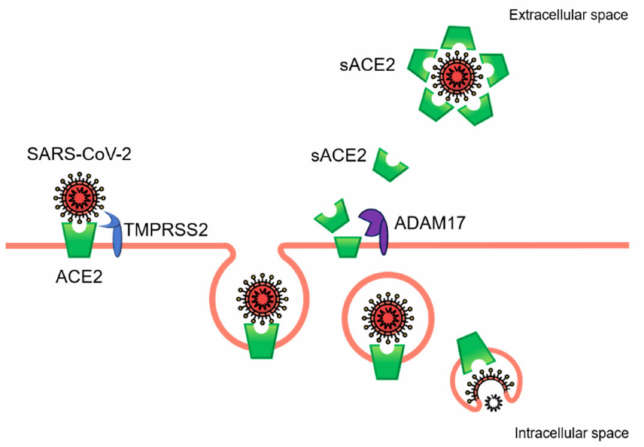
Figure 3. The fate of ACE2 during SARS-CoV-2 infection. After the binding of viral spike proteins to ACE2 and the S-protein priming by the transmembrane serine protease 2 (TMPRSS2), the viral particles are endocytosed. Acidification of the endosome leads to viral and cellular membrane fusion and the release of viral single-stranded RNA into the cytosol. The internalization of ACE2 contributes to the upregulation of ADAM metallopeptidase domain 17 (ADAM17), which cleaves the extracellular portion of ACE2 from the cell membrane. The soluble form of ACE2 binds the viral spike protein, contributing to attenuate the spread of the virus by impairing viral